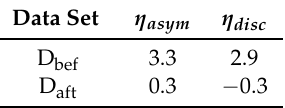
Table 2. Asymmetry index η asym (Equation (2)) and Discrepancy index η disc (Equation (3)) before and after yaw error